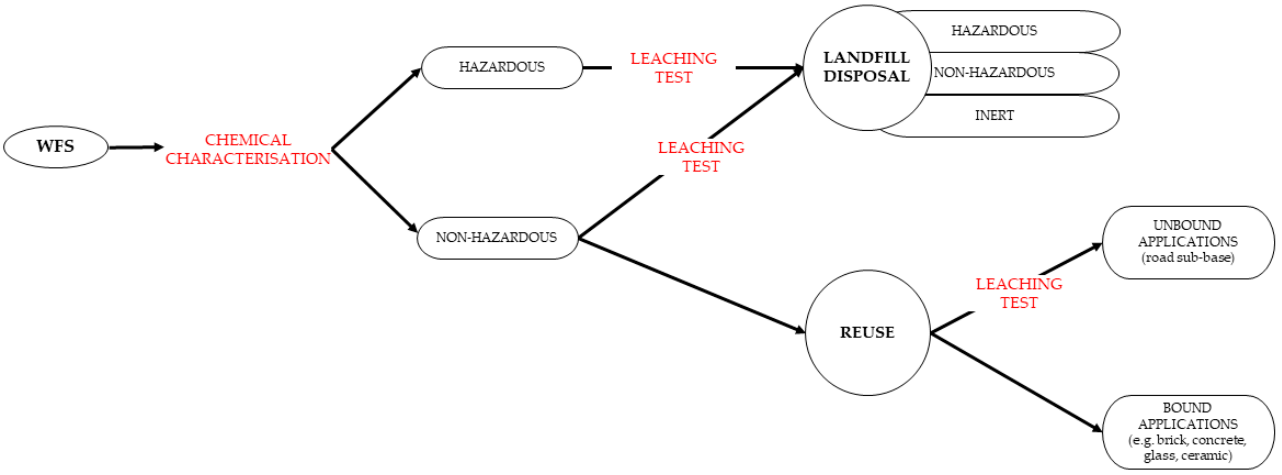
Figure 1. Schematic diagram of WFS.